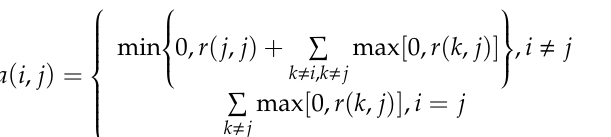
Figure 1. Flow chart of the multidimensional spatiotemporal affinity propagation (MDST-AP) algorithm. Figure1. Flowchartofthemultidimensionalspatiotemporala